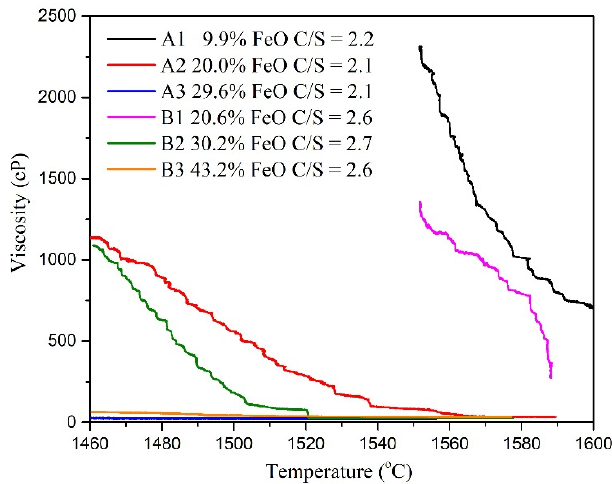
Figure 5. Relationship between temperature and viscosity.